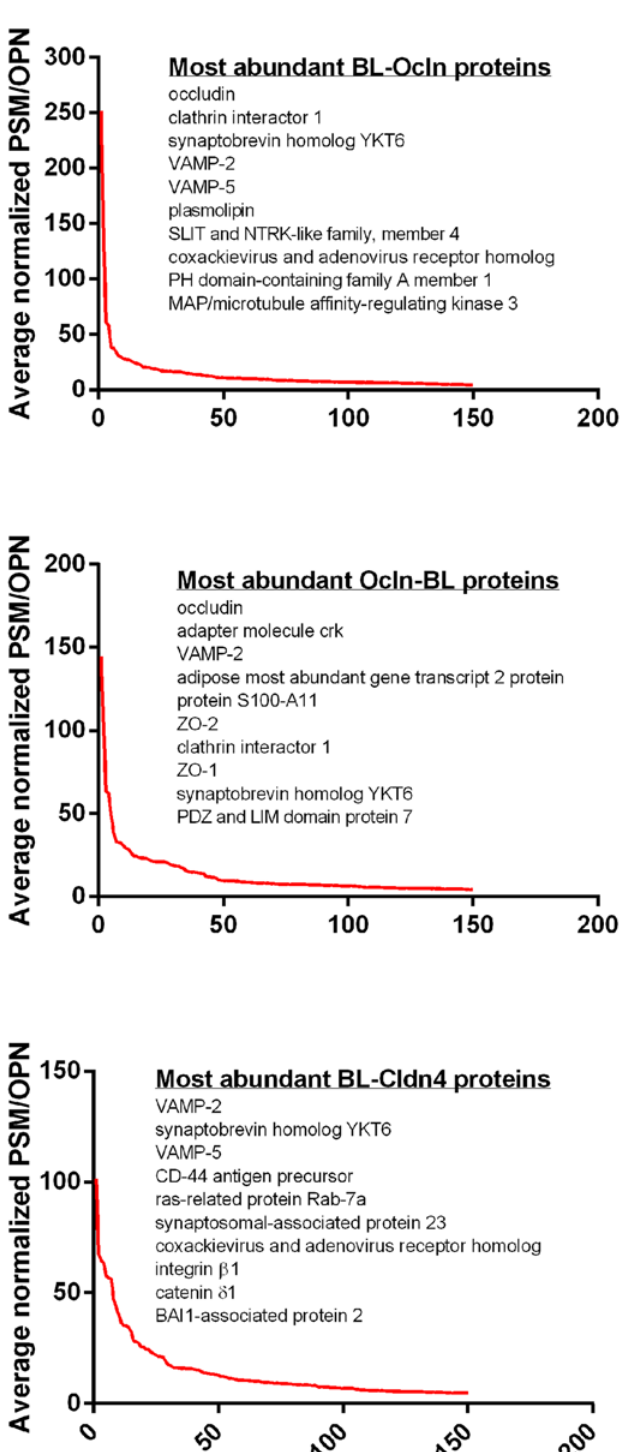
Fig 5. Relative abundance of proteins tagged by biotin ligase fusion proteins identified by mass spectrometry. The y-axis is proportional to the amount of protein recovered and was calculated as follows: PSMs from each of the three isolations were normalized (PSM for each protein/total PSMs for that isolation), these normalized PSMs were averaged between the three runs and then divided by the number of theoretical observable peptide number falling in the size range detectable by MS and this value multiplied by